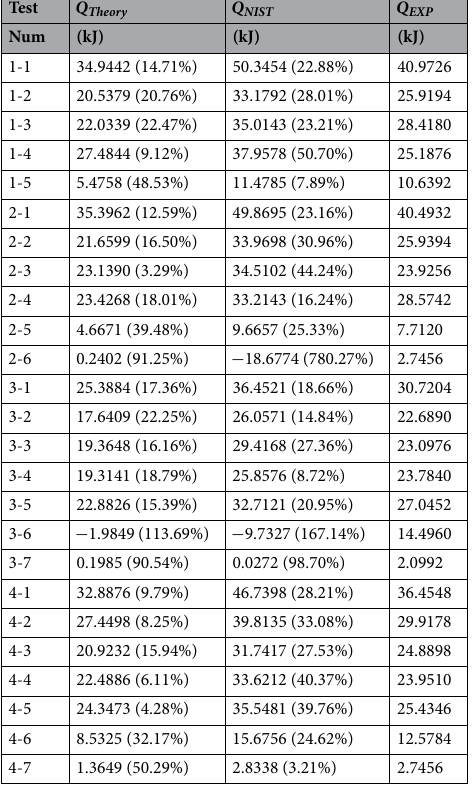
Table 11. The combined energy input Q (kJ) into the CO 2 , defined with Eqs. (13) and (14), using the theory defined in Eq. (4), from NIST in Table 5 54 , and measured experimentally. The parentheses represent the percent (%) error with Q EXP . These tabulated results are plotted in Figure 3.